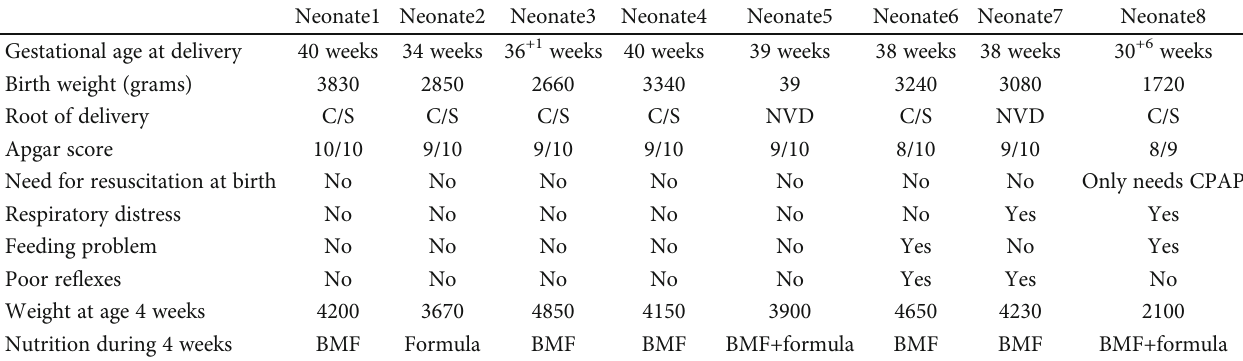
Table 1: Baseline characteristics of 8 newborns with mothers with COVID-19.